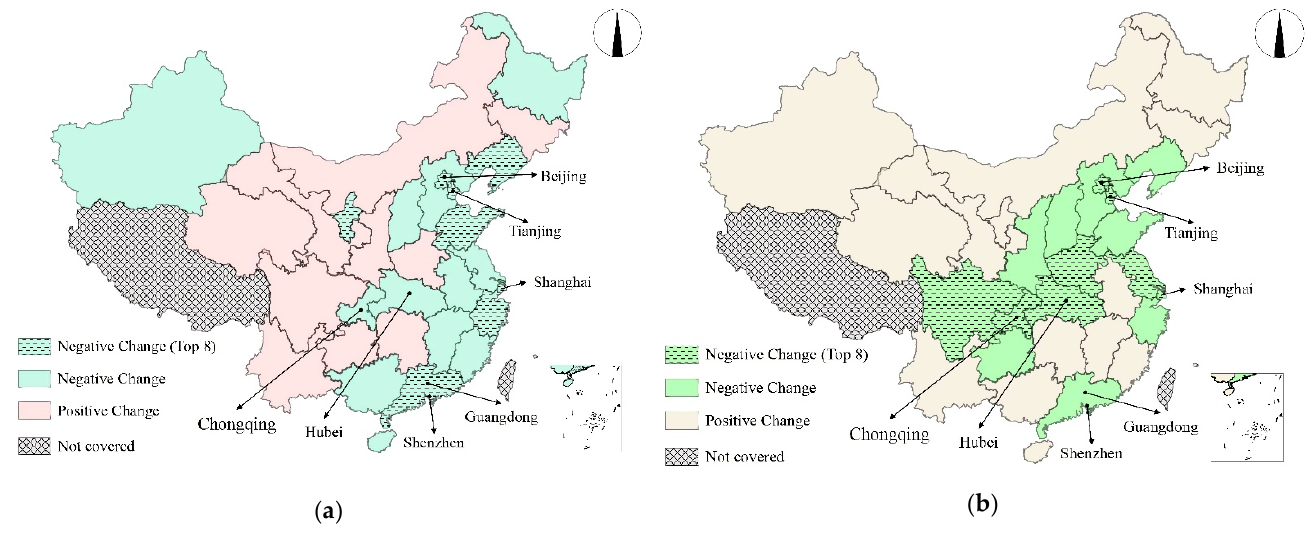
Figure 4. Spatio-temporal evolution of LUT. ( a ) Economic level tendency; ( b ) green development tendency.